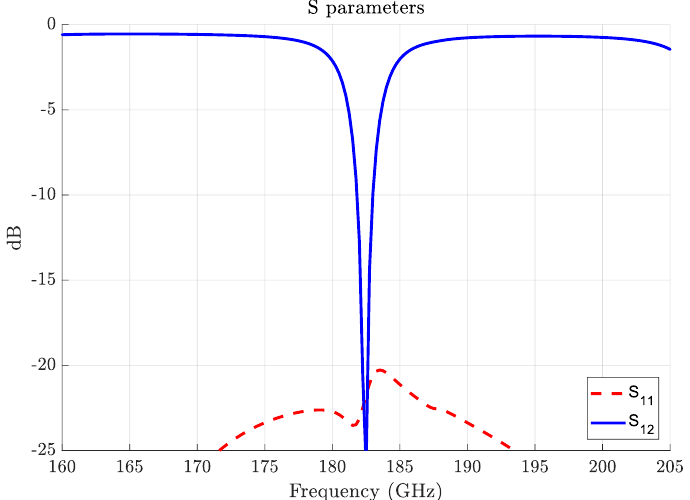
Figure 5. Frequency-dependent S-parameters showing millimeter-wave coupling to the resonator.